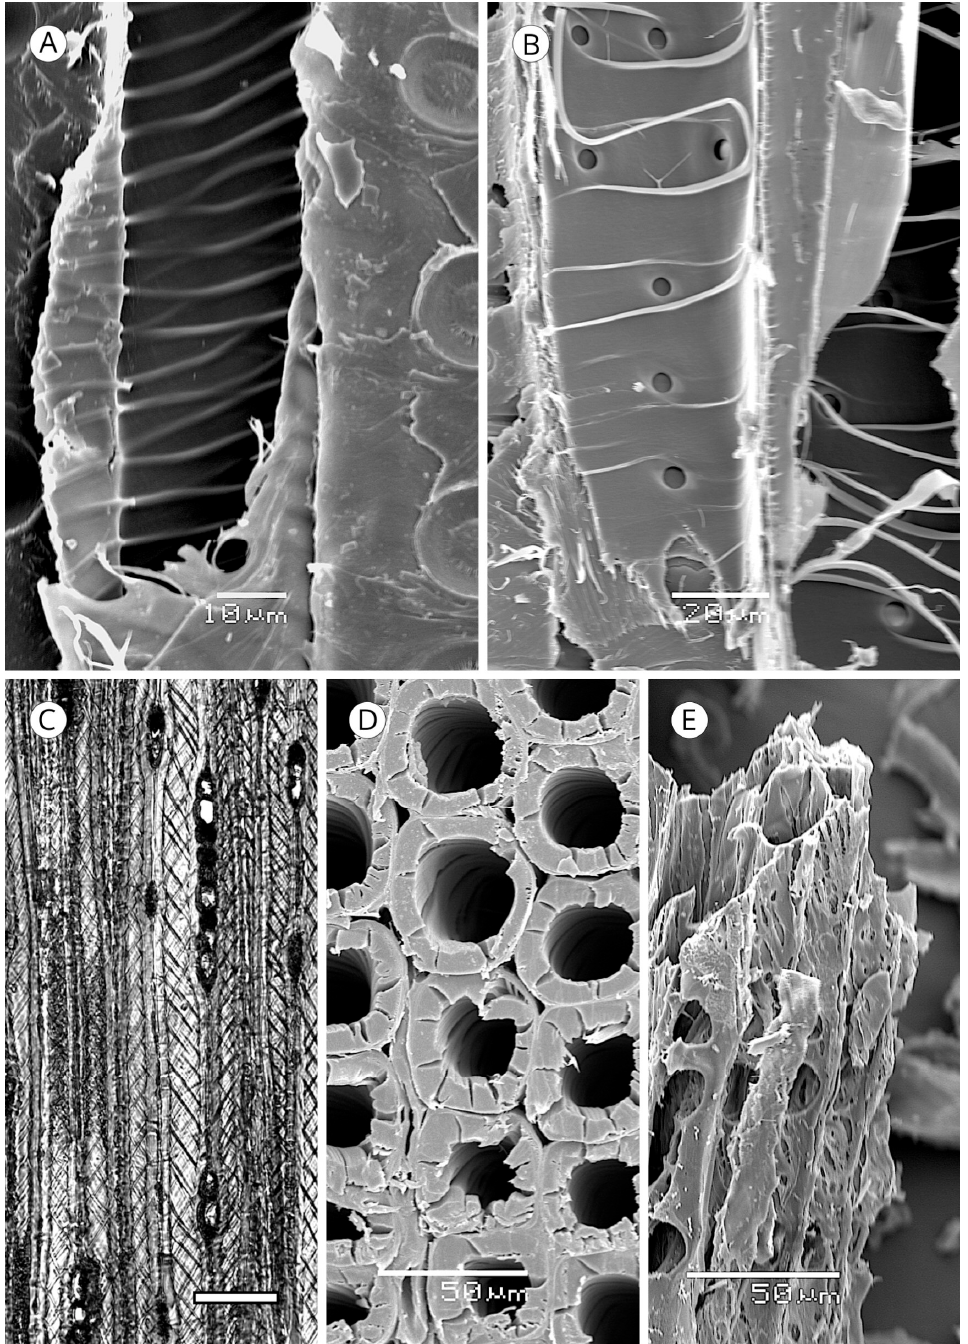
Figure 21. Helical thickenings and spiral grooves. ( A ) Helical thickenings in Pseudotsuga sinensis Dode. (SEM); ( B ) Helical thickenings in Torreya nucifera (L.) Siebold and Zucc. (SEM); ( C ) Spiral grooves in Neocallitropsis pancheri (Carrière) de Laub.; ( D ) Spiral grooves in Pinus roxburghii Sarg. (SEM); ( E ) Cavities caused by soft-rot in Pinus sylvestris L. resembling spiral grooves (SEM). Scale bars. ( C ) = 150 μ m.